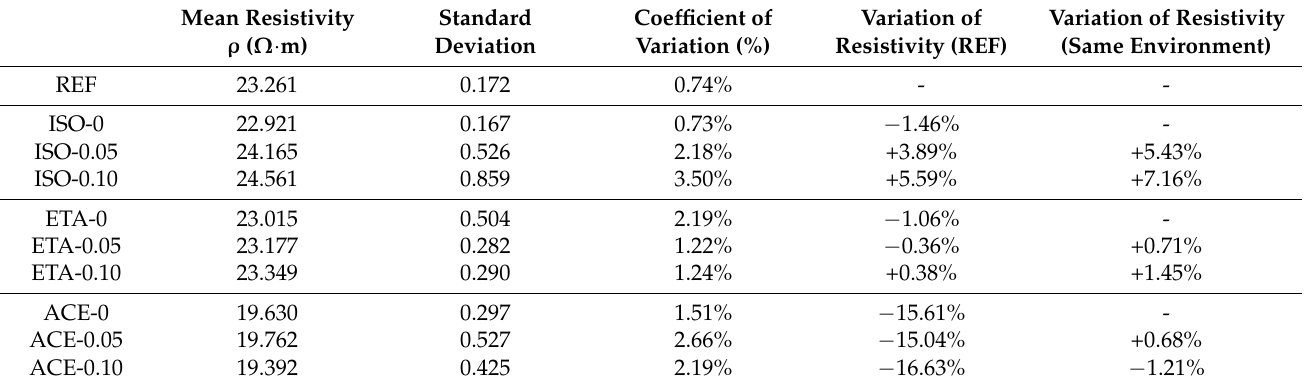
Table 3. Results of the electrical-volumetric conductivity